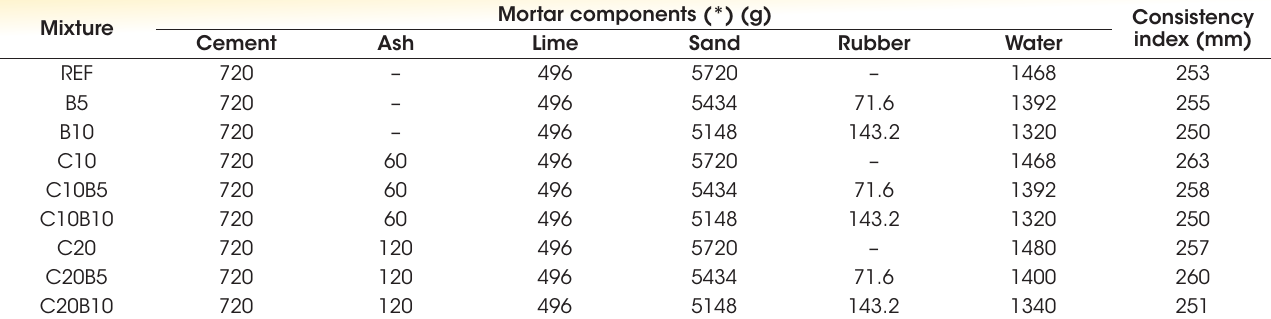
Fresh-State mortar properties